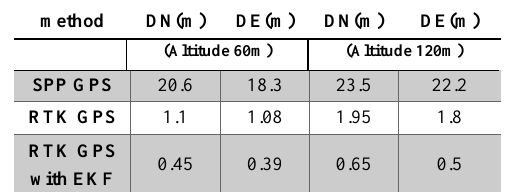
Table 3: Standard deviation in geolocation for selected target in 60m altitude and 120m altitude